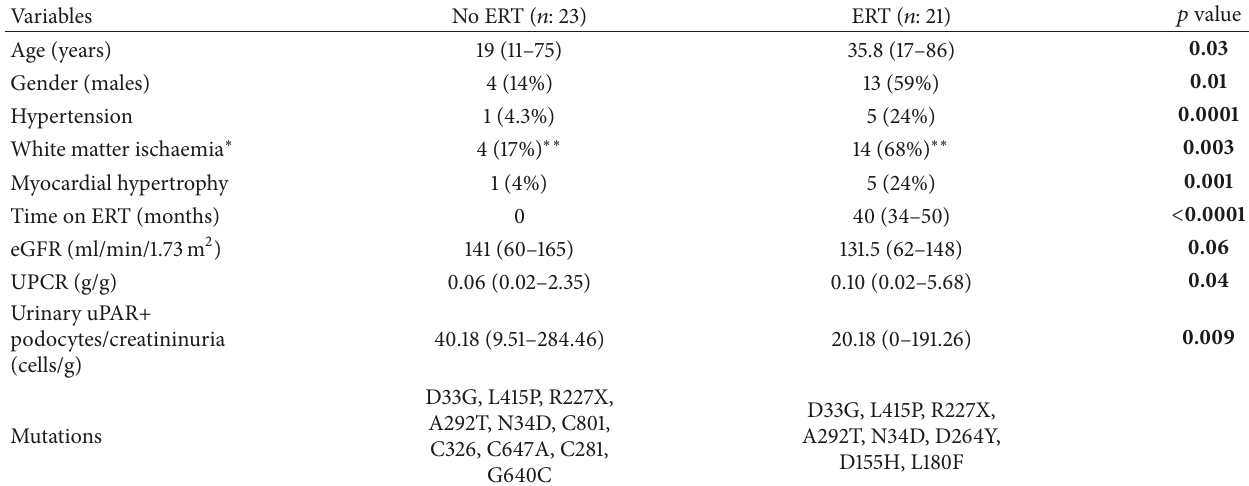
Table 2: General characteristics of untreated (no ERT) and ERT-treated Fabry